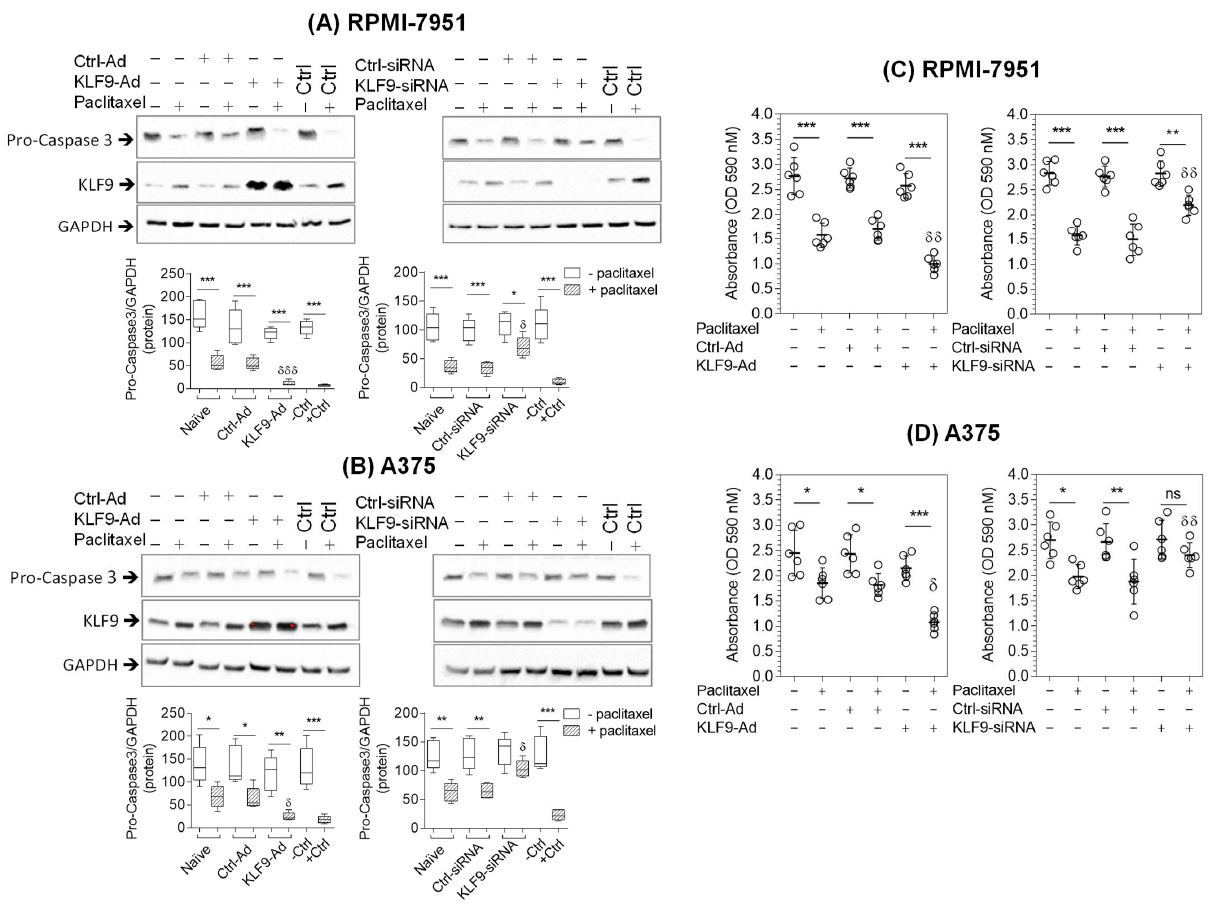
Figure 3. KLF9 overexpression augmented the paclitaxel apoptotic effect, while KLF9 knockdown attenuated such an effect on RPMI-7951 and A375 cells. Western blot analysis of cell lysates prepared from RPMI-7951 ( A ) or A375 cells ( B ). Cells were transduced with KLF9-overexpressing adenovirus (KLF9-Ad) or transfected with KLF9-siRNA, followed by 24 h treatment with paclitaxel (100 nM). Negative (-Ctrl) or positive control (+Ctrl) samples were prepared from naïve untreated or paclitaxel treated cells (100 nM for 72 h), respectively. Box and whiskers graphs (left-bottom) illustrate the densitometric analysis of caspase-3 band intensity. The MTT assay was performed as described in the materials and method section. The MTT assay shows the effects of adenoviral overexpression or siRNA knockdown of KLF9 on cell viability in RPMI-7951 ( C ) or A375 cells ( D ) treated with paclitaxel (100 nM) for 24 h before reading the MTT absorbance. Data ( n = 6), scatter plots, right panels, represent means ( ± SD). ns p > 0.05, * p ≤ 0.05, ** p ≤ 0.01, *** p ≤ 0.001. δ p ≤ 0.05, δδ p ≤ 0.01, δδδ p ≤ 0.001 vs. the absorbance values of naïve cells treated with paclitaxel. Like RPMI-7951 cells, A375 cells also showed a similar reduction in pro-caspase-3 levels after paclitaxel treatment, with 64.46% ( p ≤ 0.003) reduction in naive cells